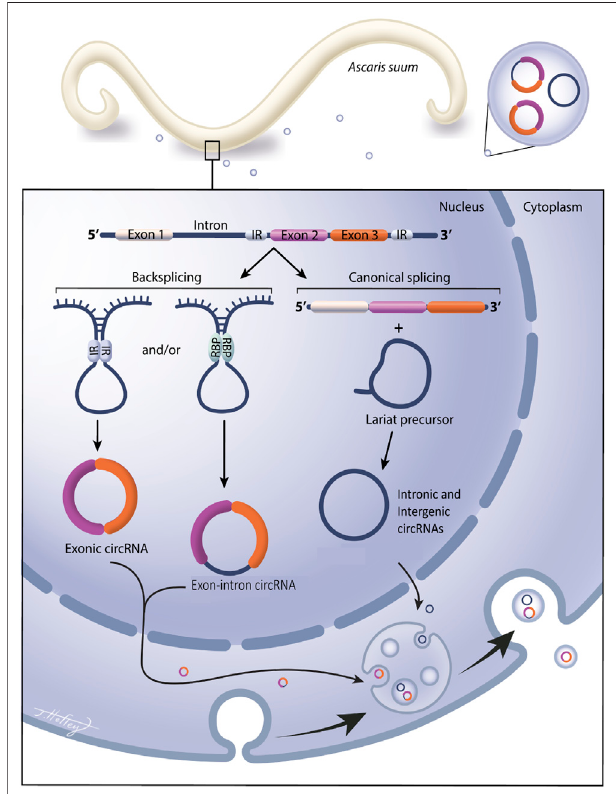
FIGURE1 | Circular RNAs are expressed inthe gastrointestinal parasitic nematode Ascaris suum and secreted into the host environment via extracellular vesicles. Circular RNA (circRNA) are covalently closed circular RNArings,withnoopen5 ′ or3 ′ ends.TheydonotcontainapolyAtailor a 5 ′ cap and are extremely stable and less prone to degradation than linear RNA species. Exonic circRNAs contain only exonic RNA, intergenic circRNAs and intronic circRNAs contain only introns. Exonic, exon-intron circRNAs are generated from a back splicing event where inverted repeats (IR) or RNA binding proteins (RBP) form a semi-closed covalent ring, allowing for downstream splice donor site to attack upstream slice acceptor site, forming the closed circRNA structure. Intronic and intergenic circRNAs are formed from lariat precursor molecules during linear splicing. Our data show exonic, intergenic and intronic circRNAs are expressed in Ascaris tissue and are also packaged into parasitic EV cargo for secretion into the external